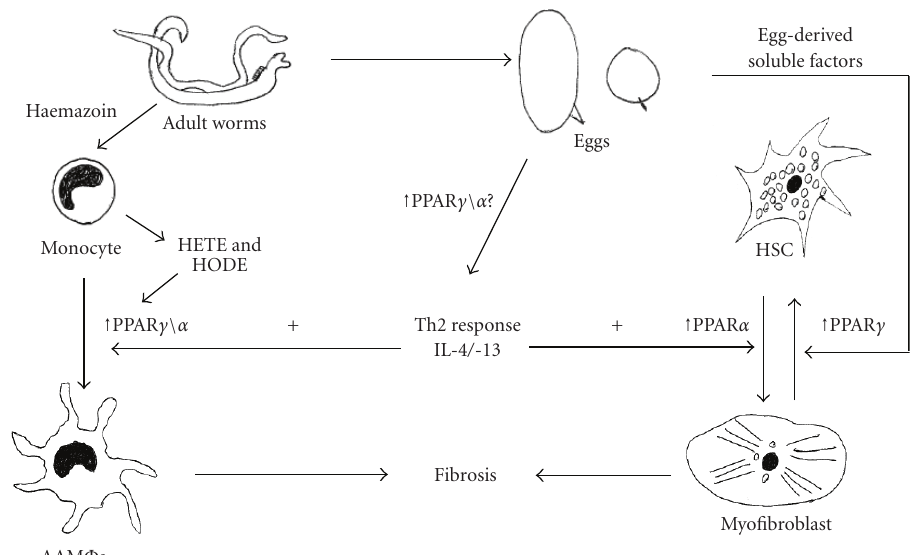
Figure 1: Summary of possible interactions in schistosomiasis with PPARs. This figure displays the possible pathways in which PPARs could be involved in schistosomiasis. PPARs could be involved in immune regulation, as they are associated in generation of a Th2 response. PPAR βγ / α both cause downregulation of Th1 cytokines and promote IL-4/-13 production. PPARs have a role in the alternate activation of macrophages where PPAR γ / α have been demonstrated to be essential for this process. In schistosomiasis, AAM Φ s have a protective e ff ect and a role in Th2 biasing. Schistosomes could interact with this activation indirectly via induction of IL-4/-13 production and directly by the breakdown products of hemozoin, which can interact with PPAR γ / α . In terms of pathology, the PPARs could interact with the transdi ff erentiation process of HSCs into fibrogenic myofibroblasts. They could limit this process by inhibiting transdi ff erentiation associated with increased PPAR γ , whereas PPAR α would be associated with generation of the fibrogenic